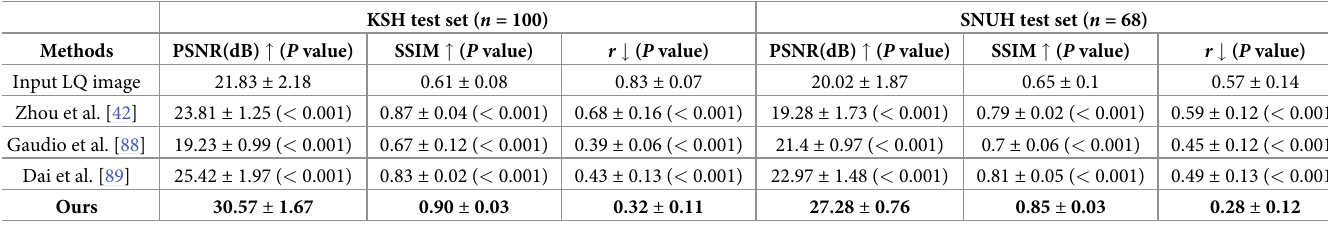
Table 1. Quantitative comparison on private